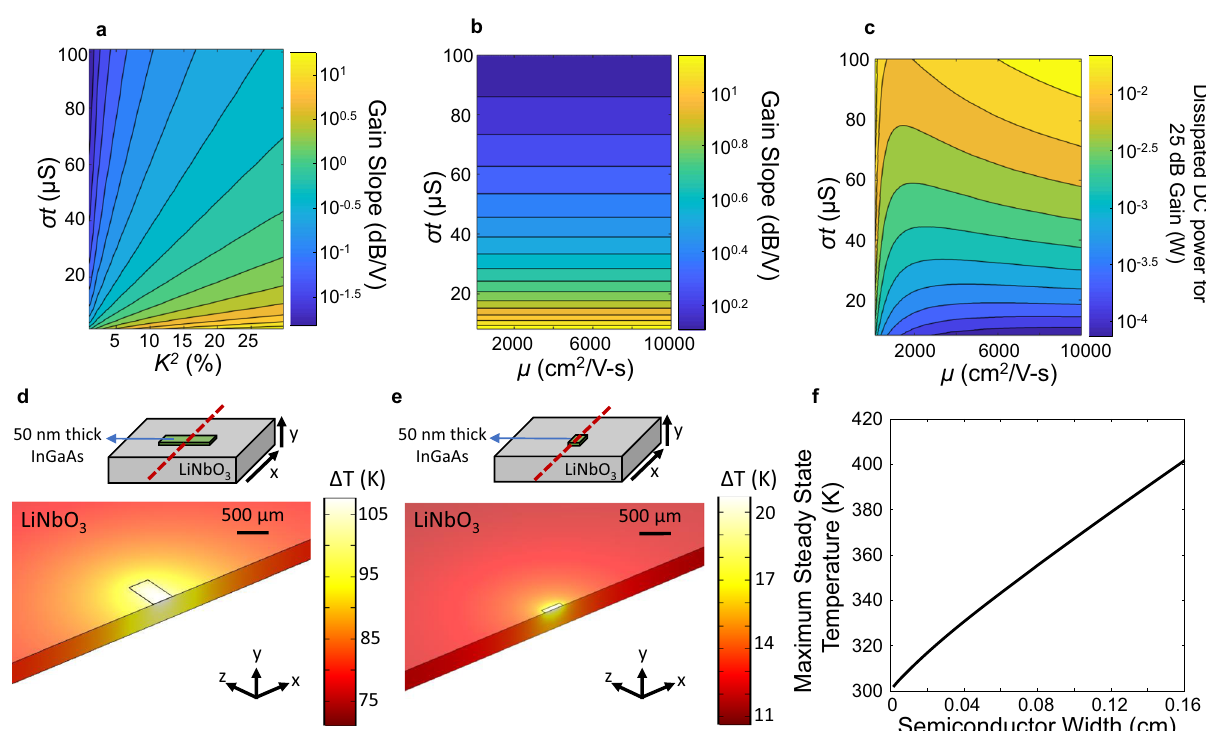
Fig. 2 Material parameters and geometry optimization. Contour plots of the ( a ) gain slope as a function of σ t and K 2 ( b ) gain slope as a function of σ t and μ , and ( c ) dissipated DC power for 25 dB of gain as a function of σ t and μ . The simulated steady-state distribution of the temperature difference ( Δ T) is shown for a semiconductor width of ( d ) 0.16 cm and ( e ) 0.024 cm where the dashed-red line denotes the axis for both the propagation of the acoustic wave and the simulated cross-section along with ( f ) a plot of the maximum steady-state temperature as a function of semiconductor width from 0.0016 cm to 0.16